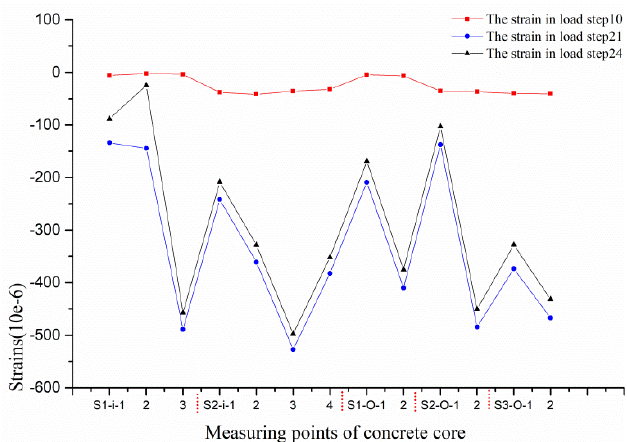
Figure 18. Comparison of the strain before and after the tensioning operation.